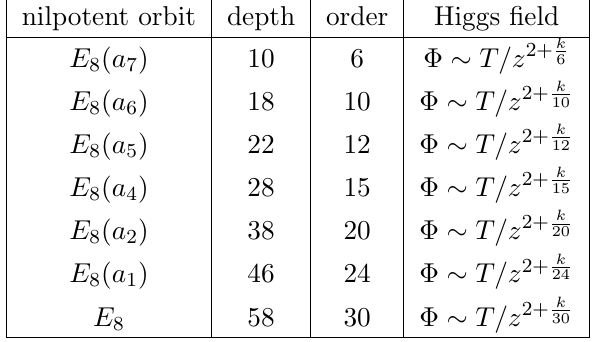
Table 13 . Summary of nilpotent elements of regular semi-simple type in E 8